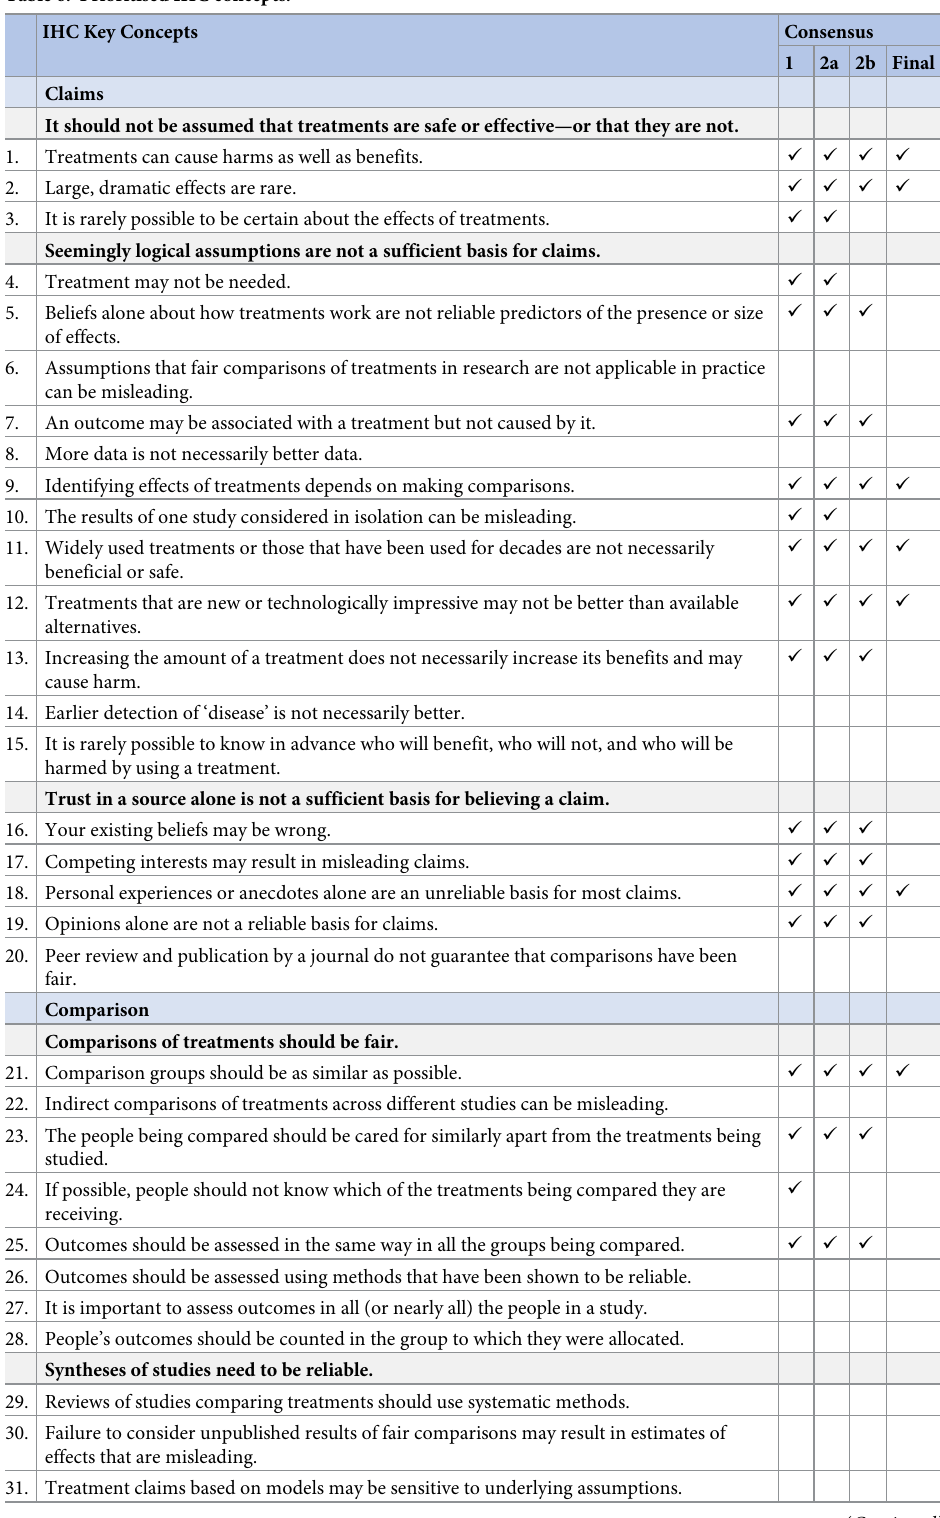
Table 6. Prioritised IHC